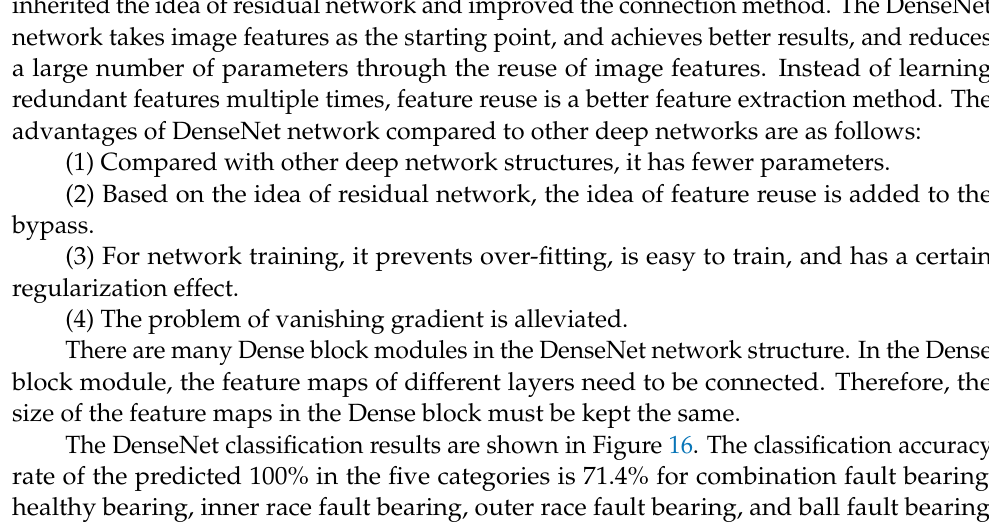
Figure 16. DenseNet classification results in confusion matrix; the accuracy rate is 92%.